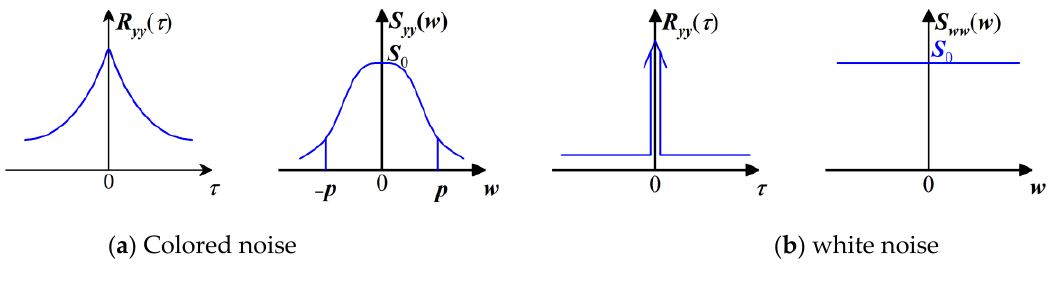
Figure 2. Colored and white noises.